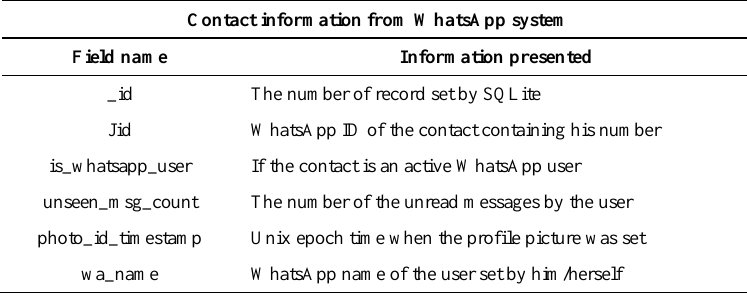
Table 6. Structure of the contacts wa.db - Information set by WhatsApp